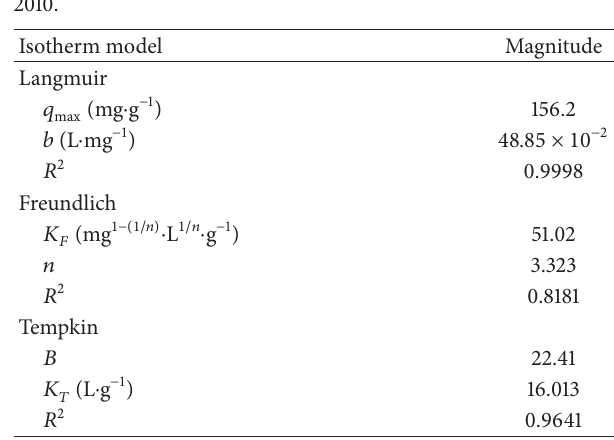
freundlich isotherm: Table 2: Parameters of the Langmuir and Freundlich isotherm models for the adsorption of U(II) ion by CAB-impregnated XAD-